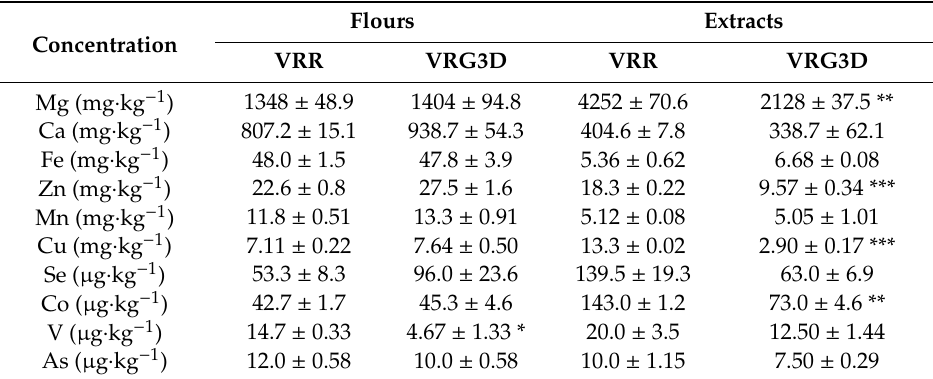
Table 4. Mineral content of raw and 3d-germinated mung bean flours and extracts. Flours Extracts Concentration